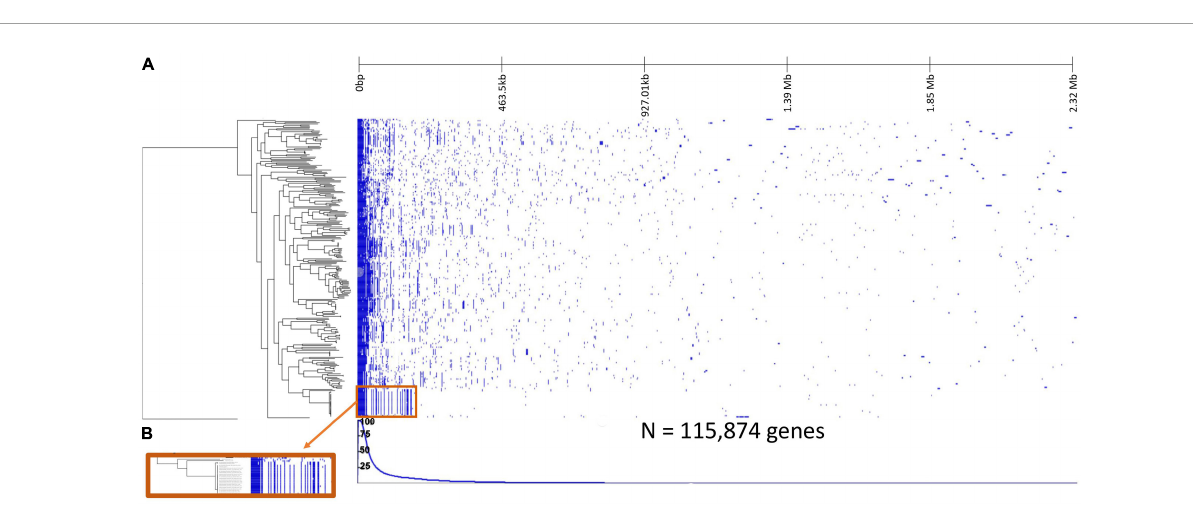
FIGURE2 Pangenome analysis of 252 Sphingomonas genomes and the Rhodospirillum centenum SW outgroup. (A) Gene presence-absence heatmap where vertical blue lines represent presence of a gene within rows corresponding to the Sphingomonas genome, and white reflects gene absence. The line graph underneath indicates the percentage of strains possessing the corresponding gene. (B) Close-up of the gene patterns within a clade shows how clades contain similar gene